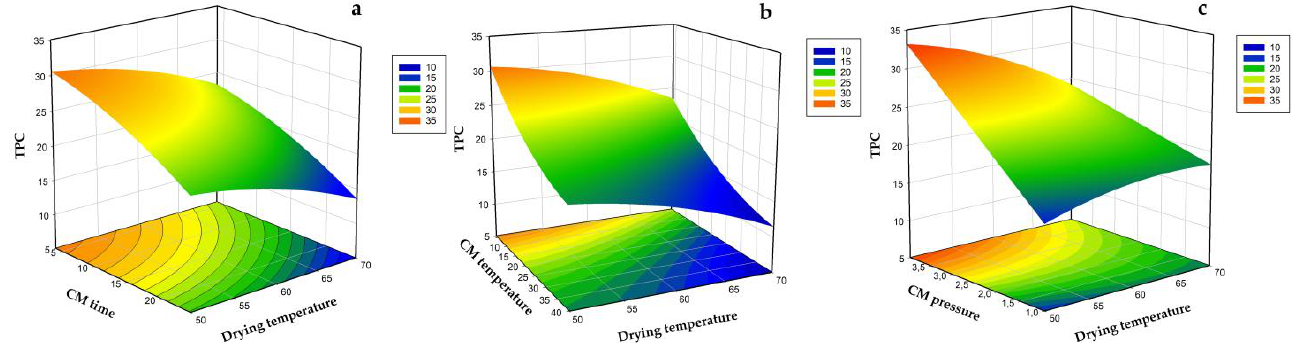
Figure 3. Influence of ( a ) CM time (h) and drying temperature (°C), ( b ) CM temperature (°C) and drying temperature (°C), and ( c ) CM pressure (bar) and drying temperature (°C) on TPC (mg GAE/g DM) of dried strawberries with CM pre-treatment.